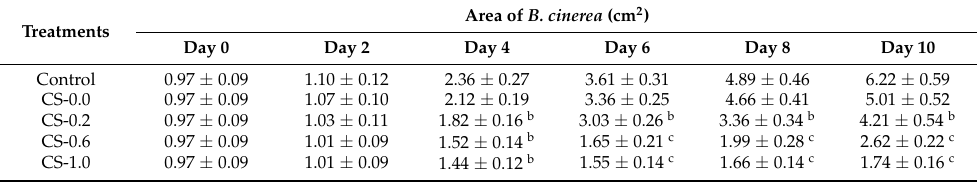
Table 2. Inhibition efficacy of CS films containing PFEO against B. cinerea on PDA over 10 days a .